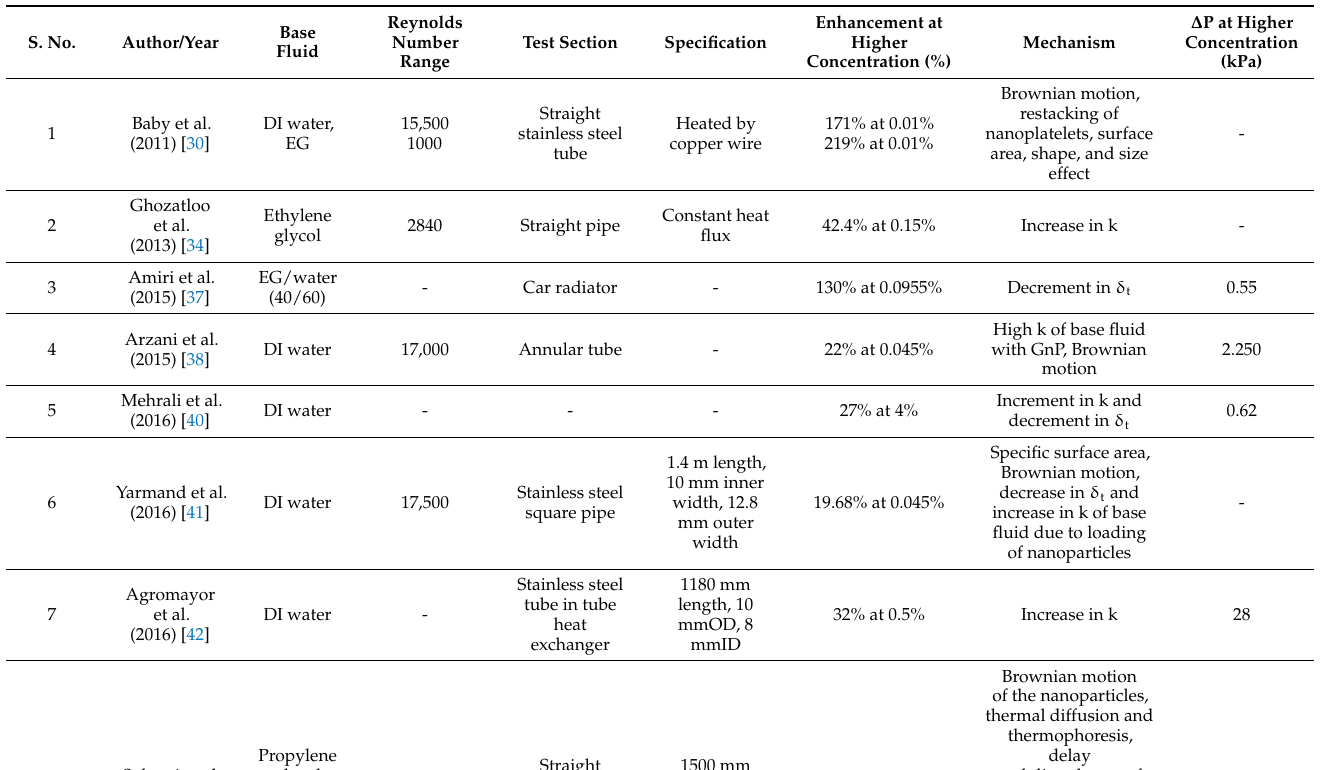
Table 11. Summary of published literature on Convective Heat Transfer Characteristics of Graphene- based